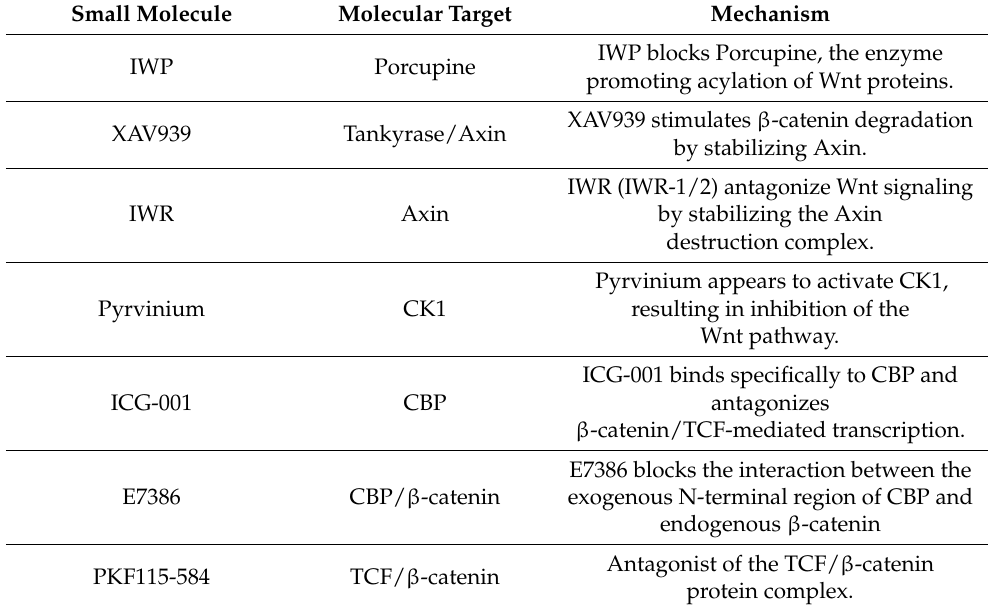
Table 1. Small molecule Wnt pathway inhibitors. Small